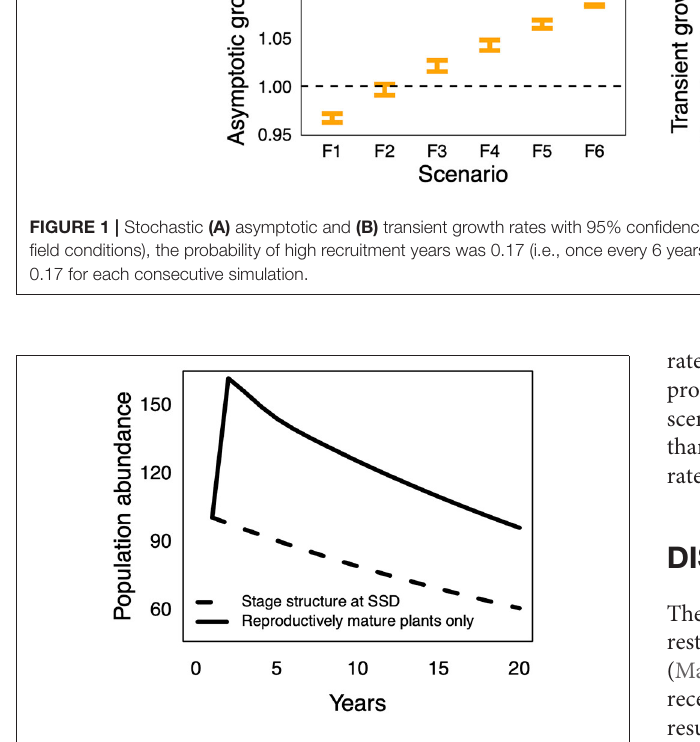
FIGURE 2 | Change in population abundance over time for a plant reintroduction established with mature plants only compared to a population at a stable stage distribution from time t to time t + 20 years. Differences in abundance illustrate the effect of population amplification on the density of plant reintroductions over